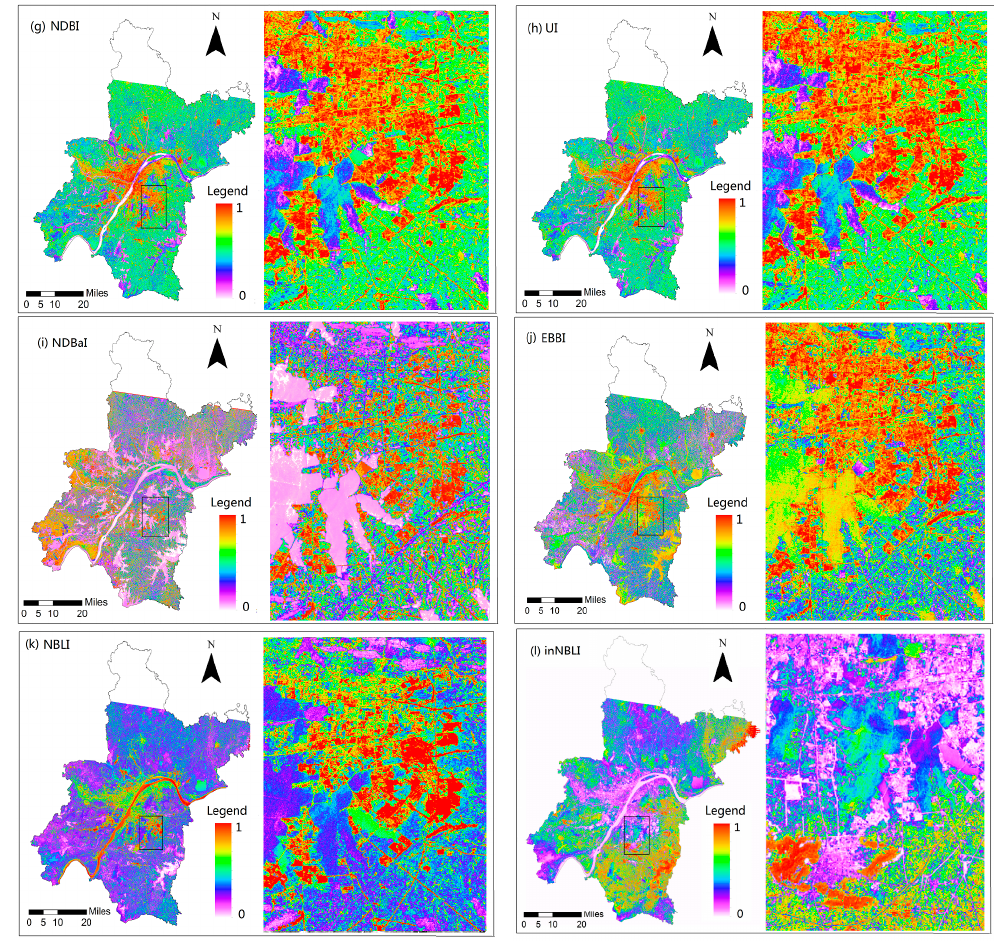
Figure 4. Index images in color: ( a ) MNDWI, ( b ) NDWI1, ( c ) NDWI2, ( d ) NDVI, ( e ) DVI, ( f ) IBI, ( g ) NDBI, ( h )UI, ( i ) NDBaI, ( j ) EBBI, ( k ) NBLI and ( l ) inverse NBLI. The right part in each panel shows details in the subset